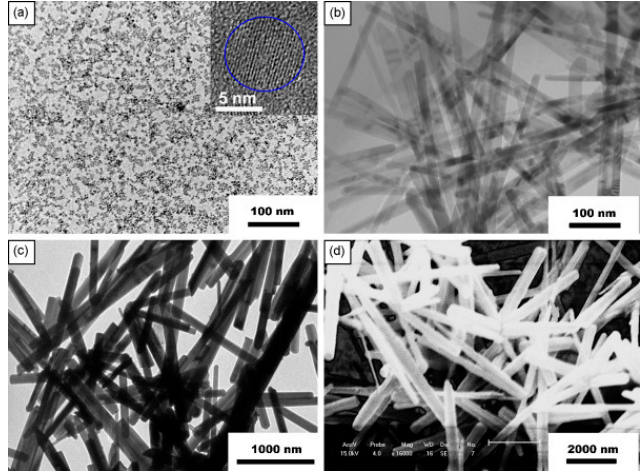
Figure 30. Transmission electron microscope (TEM) of ZnO ( a ) 6 nm nanoparticles (NP-6); ( b ) 40 nm nanorods (NR-40); ( c ) 100 nm nanorods (NR-100); ( d ) SEM of 300 nm ZnO nanorods (NR-300). Reproduced with permission from [13].